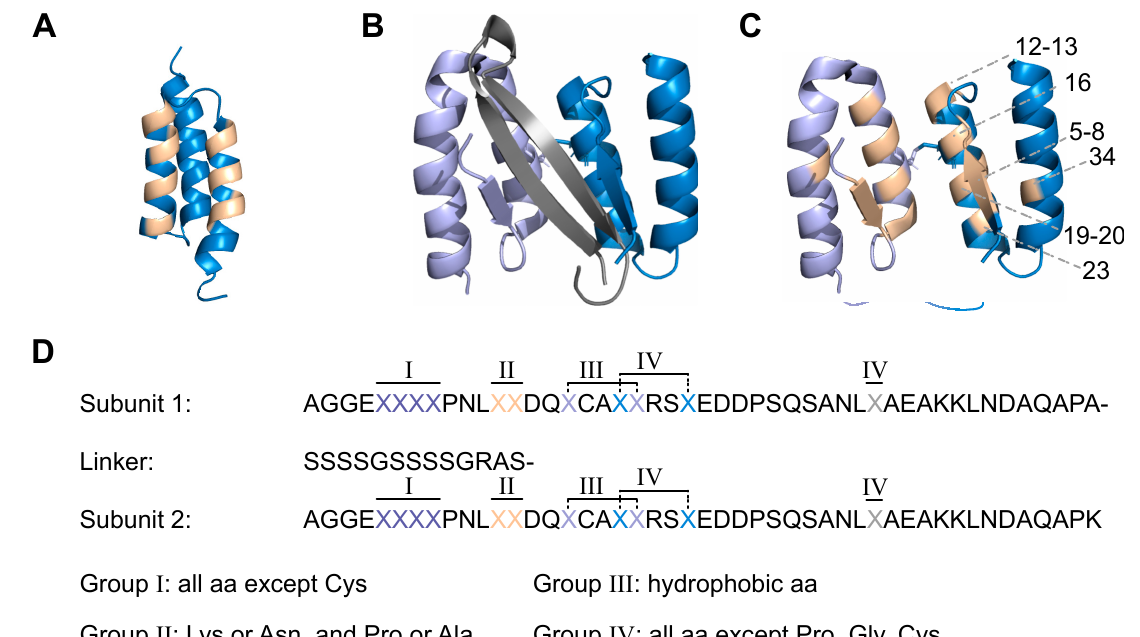
Figure 1. ( A ) Structure of conventional affibody molecule with randomized positions marked in beige for comparison (PDB:2B89). ( B ) Two subunits of Z A β 3 [6] (light purple and blue) in complex with amyloid beta (A β ) (grey) (PDB:2OTK). A cysteine bridge between the two subunits is shown as sticks. ( C ) The head-to-tail Sq lib with the 22 randomized positions shown in beige for the two subunits. ( D ) The randomised positions in the design and with connecting linker. Each position group has a specified distribution of amino acids. The same distribution is used for both subunits.